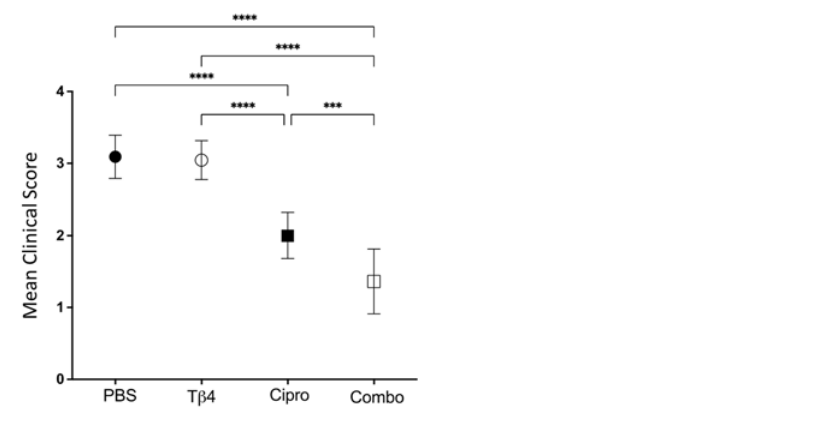
Figure 1. Disease response presented as mean clinical score. Ocular disease response of P. aeruginosa - infected B6 mice was graded at 3 days p.i. and results are represented as mean clinical scores ± SD. Treatment groups included: PBS control ( ● ), T β 4 ( ), ciprofloxacin ( ◼ ), and T β 4 + ciprofloxacin as a combo ( ◻ ). ( n = 11 corneas/group). *** p < 0.001; **** p < 0.0001.